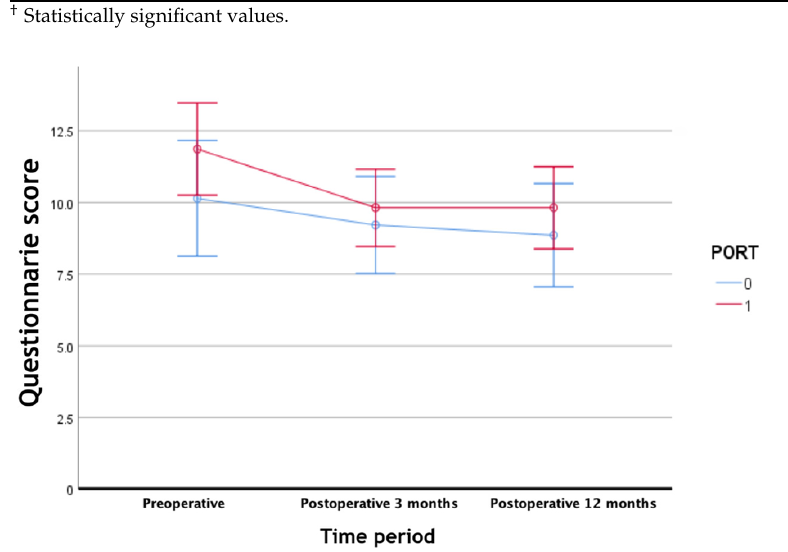
Figure 1. Questionnaire score of the two groups at different time points.